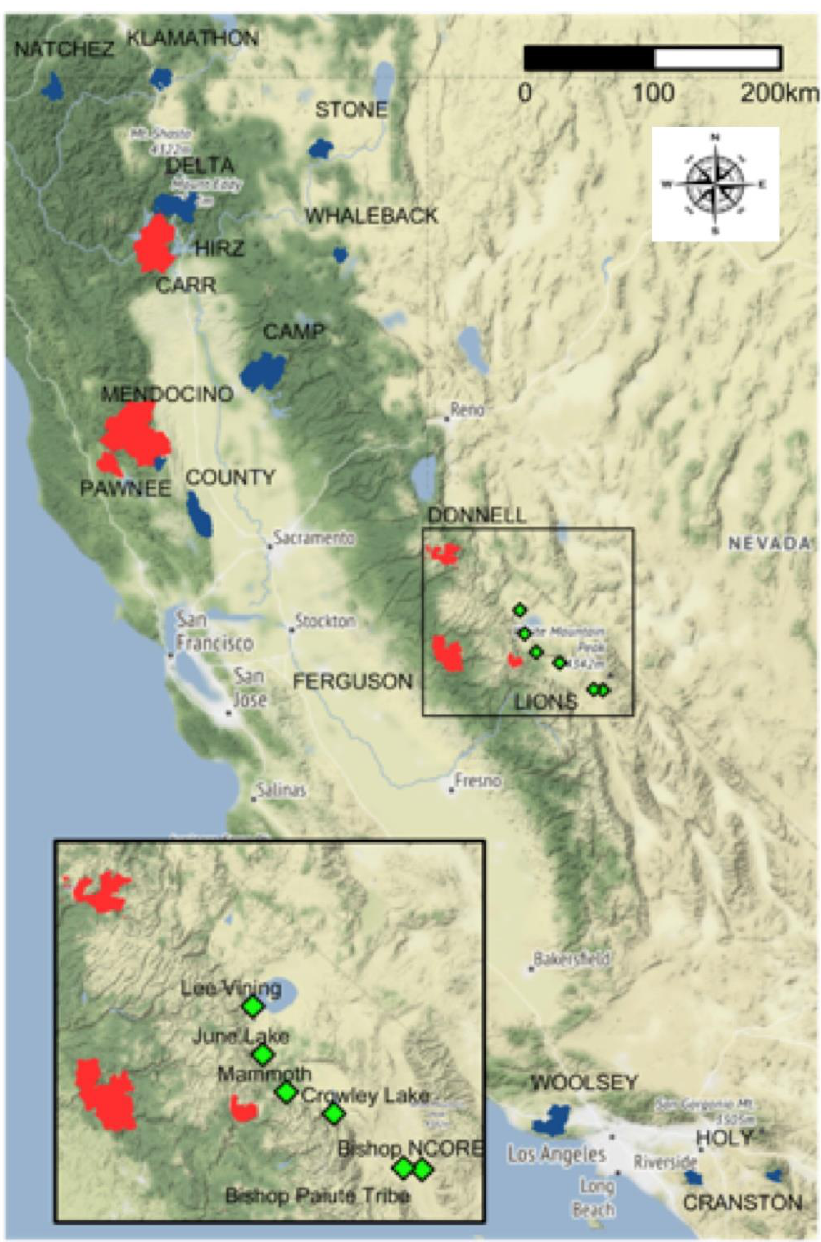
Figure 2. Location of wildland fires greater than 12,000 acres in California in 2018. Red fill: Fires included in this study; green diamonds: The six air quality monitoring sites. Source: United States Department of Agriculture, Forest Service.